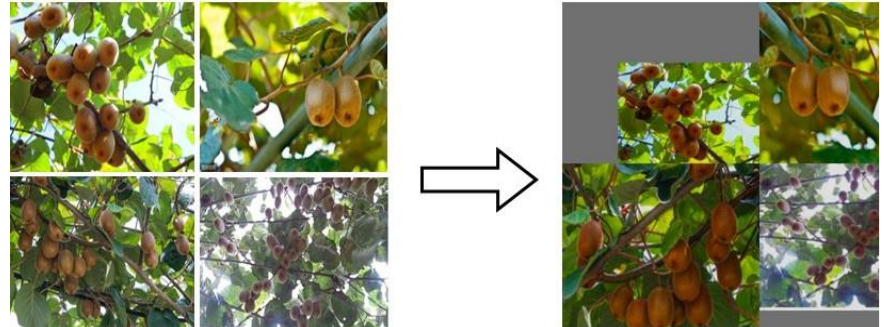
Figure 3. Mosaic data enhancement.